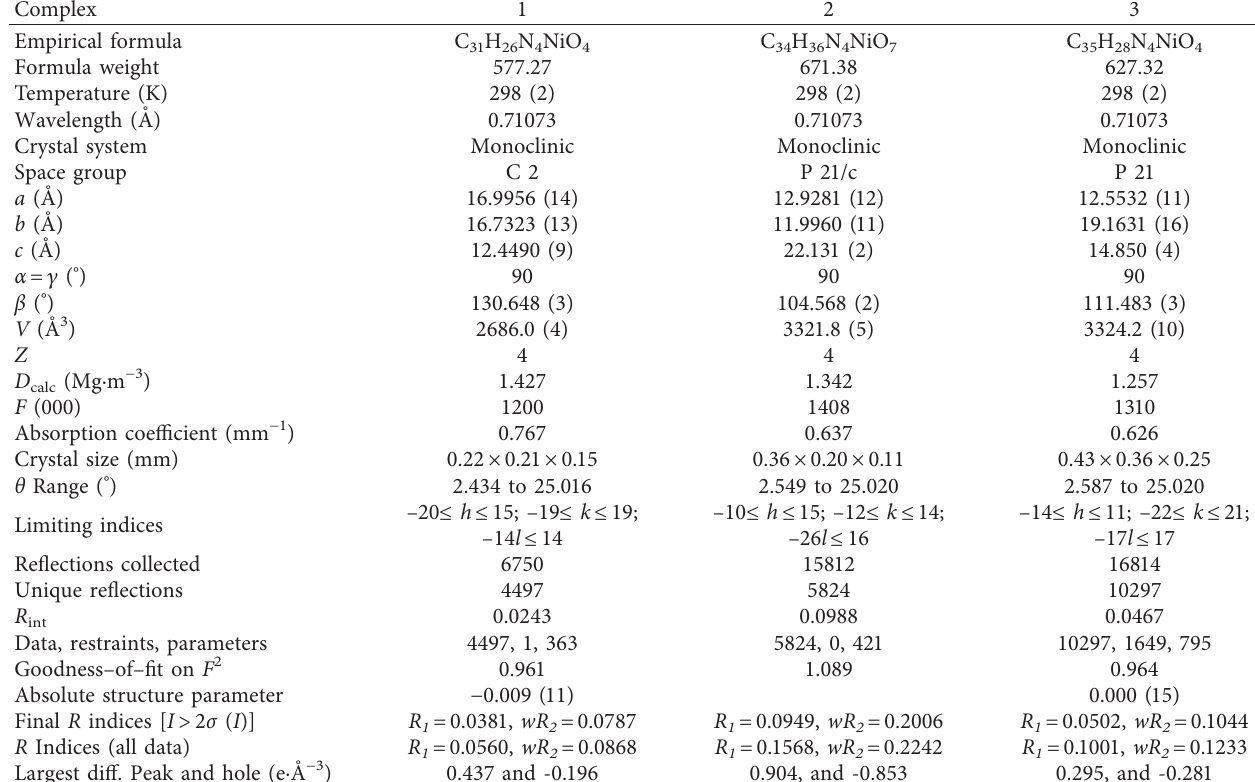
Table 3: Crystallographic and structure refinement data for complexes 1, 2, and